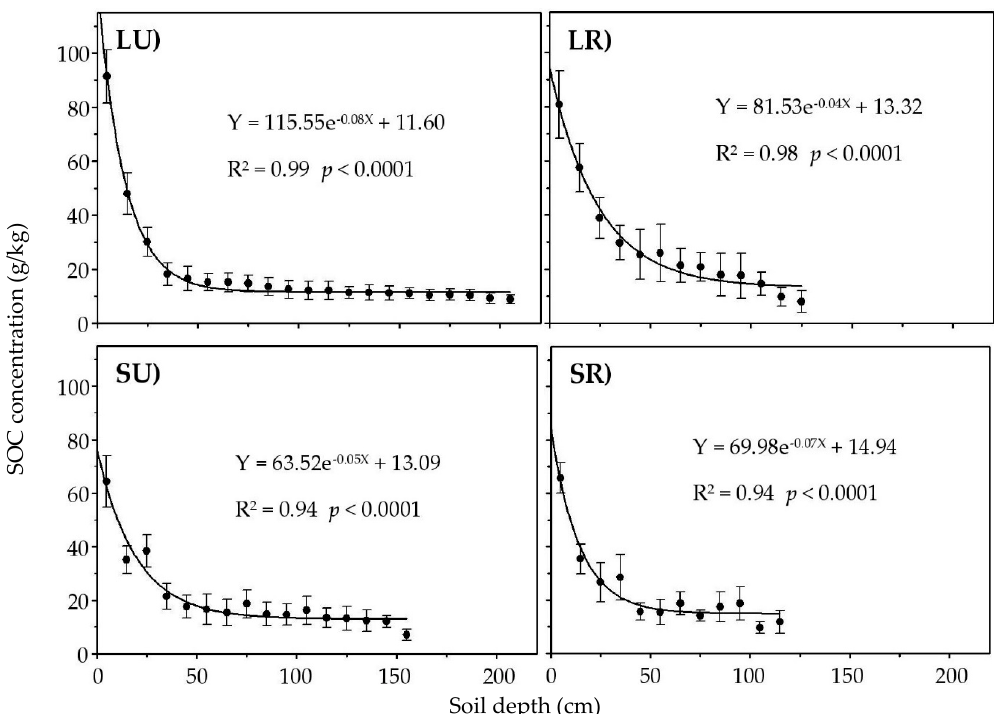
Figure 5. Exponential decay of soil organic carbon (SOC) concentration with soil depth in the four soil profiles (LU, LR, SU and SR) in a montane subtropical moist forest of southwestern China. Error bars indicate one standard